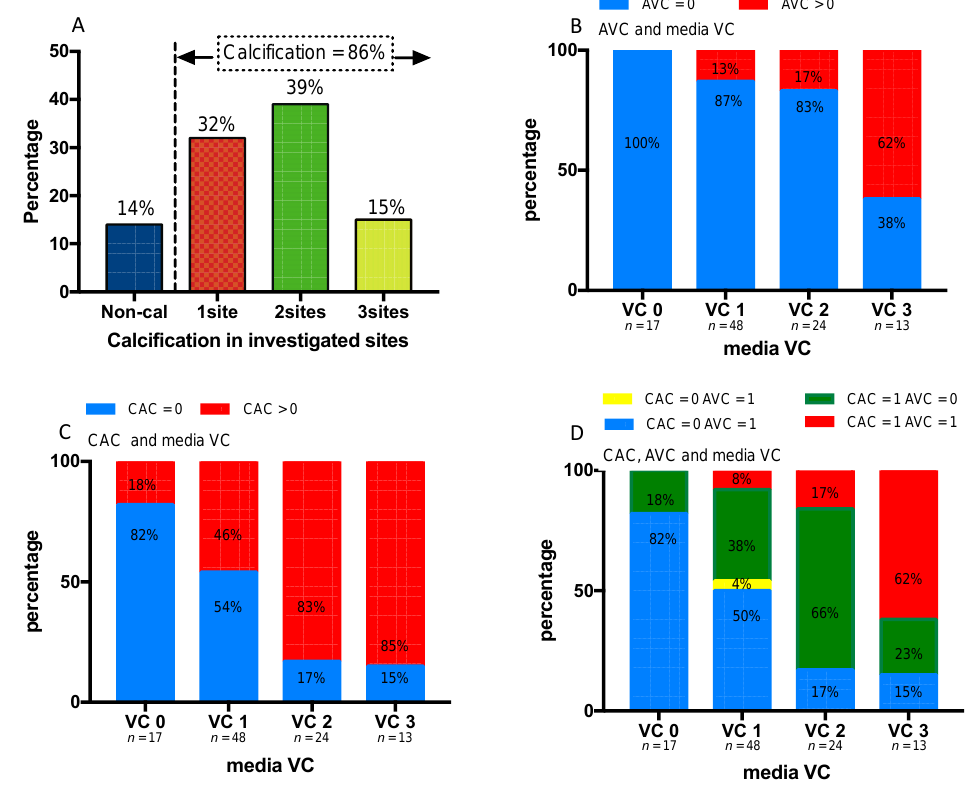
Figure 2. Prevalence of calcification at three sites, inferior epigastric artery (media vascular calcification, VC), aortic valve (AVC) and coronary artery (CAC) among 102 ESRD patients who underwent both arterial biopsies and cardiac CT imaging. ( A ) Prevalence of calcification at 0, 1, 2 or 3 of the three sites. ( B ) Prevalence of AVC with severity of media VC. ( C ) Prevalence of CAC with severity of media VC. ( D ) Prevalence of combined presence of CAC and AVC with severity media VC.